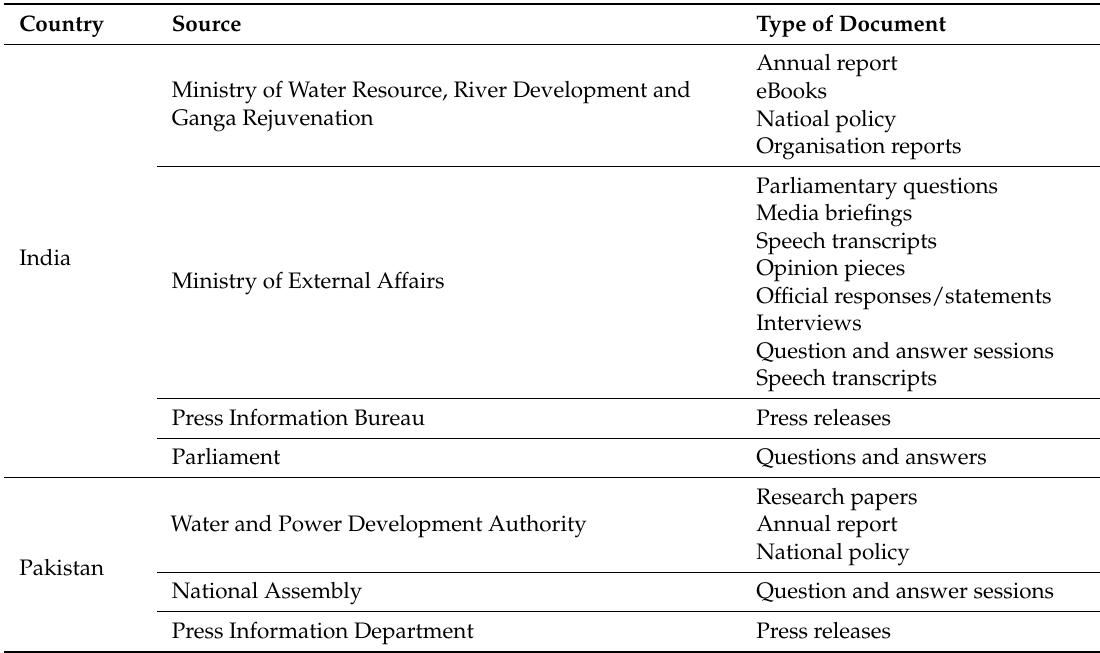
Table 1. Types of government documents